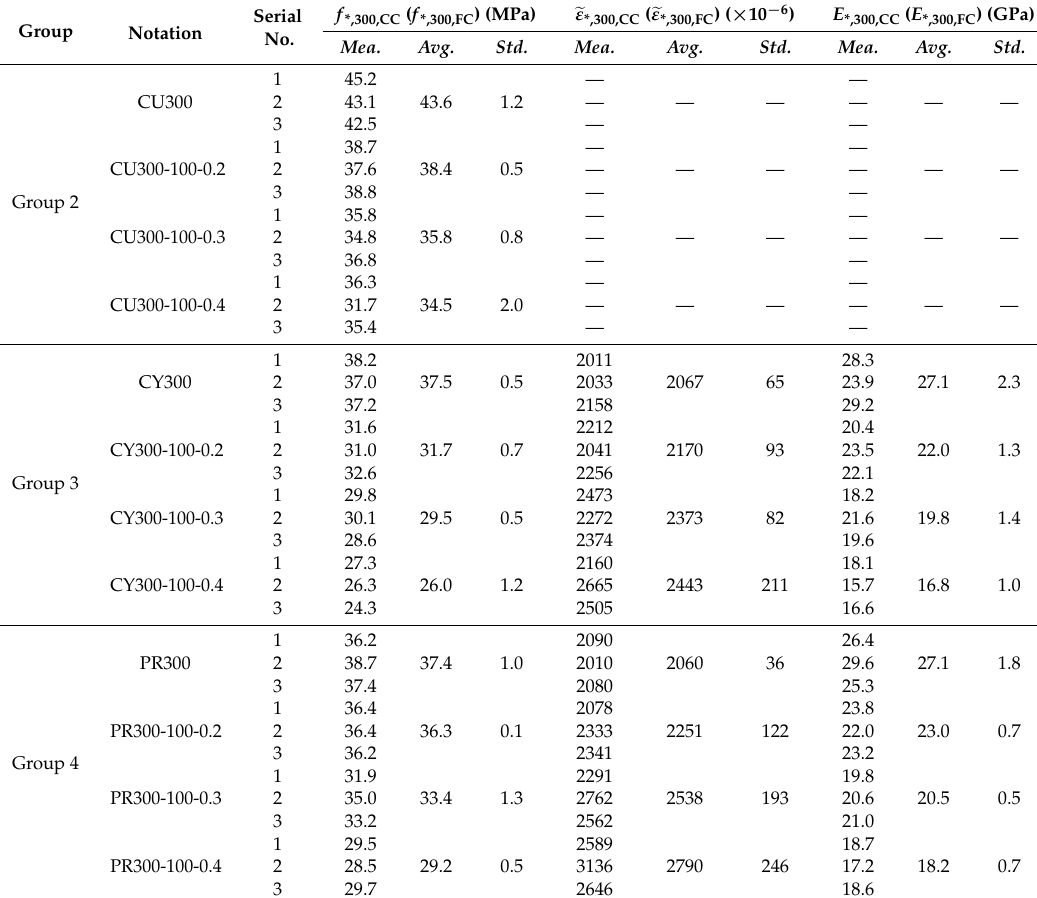
Table 4. Experimental results of specimens in Group 2, Group 3, and Group